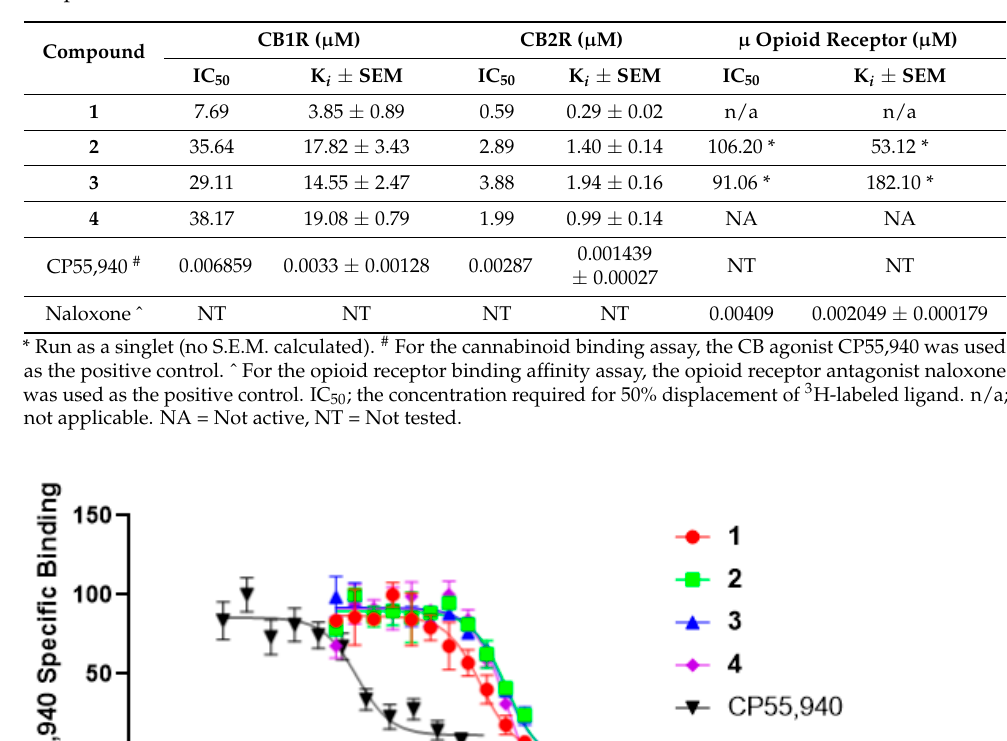
Table 2. The binding affinities (K i and IC 50 ) of selected compounds against CB1R, CB2R, and µ opioid receptors.